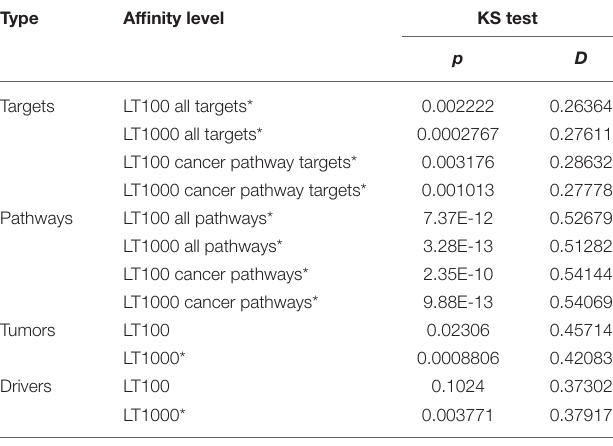
TABLE 7 | Distribution comparisons for targets, pathways, tumors and cancer